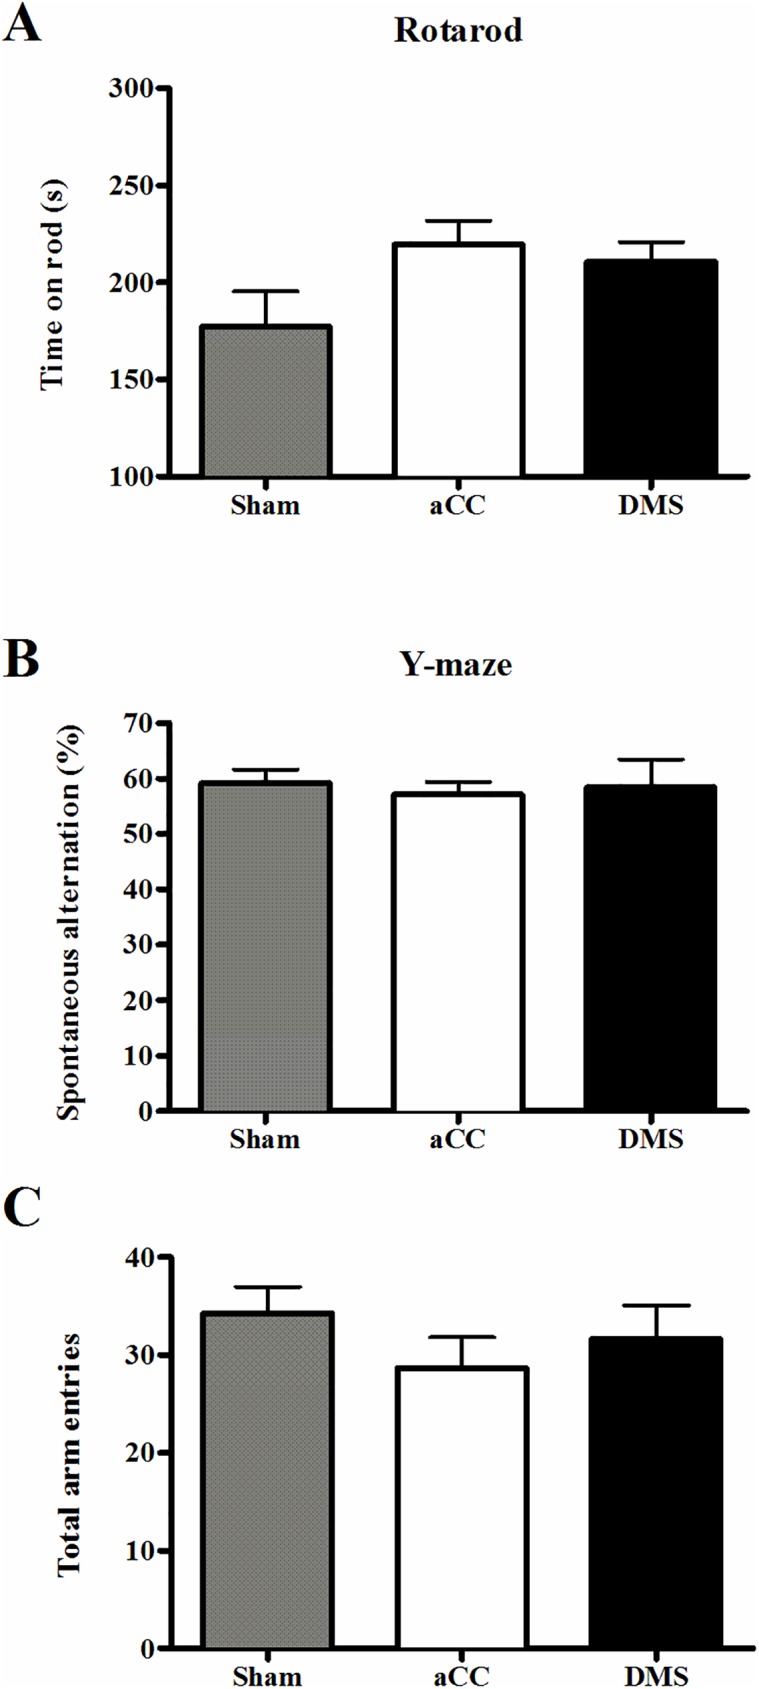
Motor performance and working memory.(A) Average fall latencies over 4 consecutive trials on the accelerated rotarod in aCC- (n = 11; white bar), DMS- (n = 9; black bar) and sham control-lesioned mice (n = 12; grey bar) indicated no motor deficits. (B) Percentage of spontaneous alternations in the y-maze showed no differences in spatial working memory between the groups, and (C) total number of arm entries showed unchanged spontaneous locomotor activity.